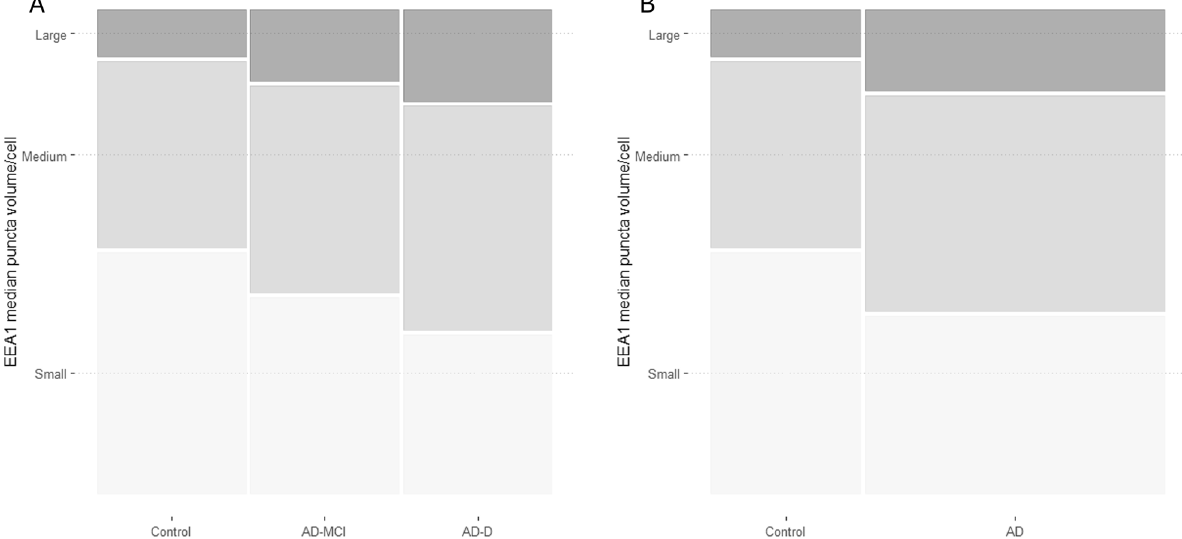
Fig. 2 Cell distribution according to their categorical median EEA1 puncta volume. The proportion of cells with a median EEA1 puncta volume ≤ 50th centile of the control group (small) is represented in light grey, the proportion of cells between the 50th and the 90th centile of the control group (medium) is represented in grey, and the proportion of cells ≥ 90th centile (large) is represented in dark grey. Panel A represents the groups according to diagnostic group, and panel B represents them according to disease